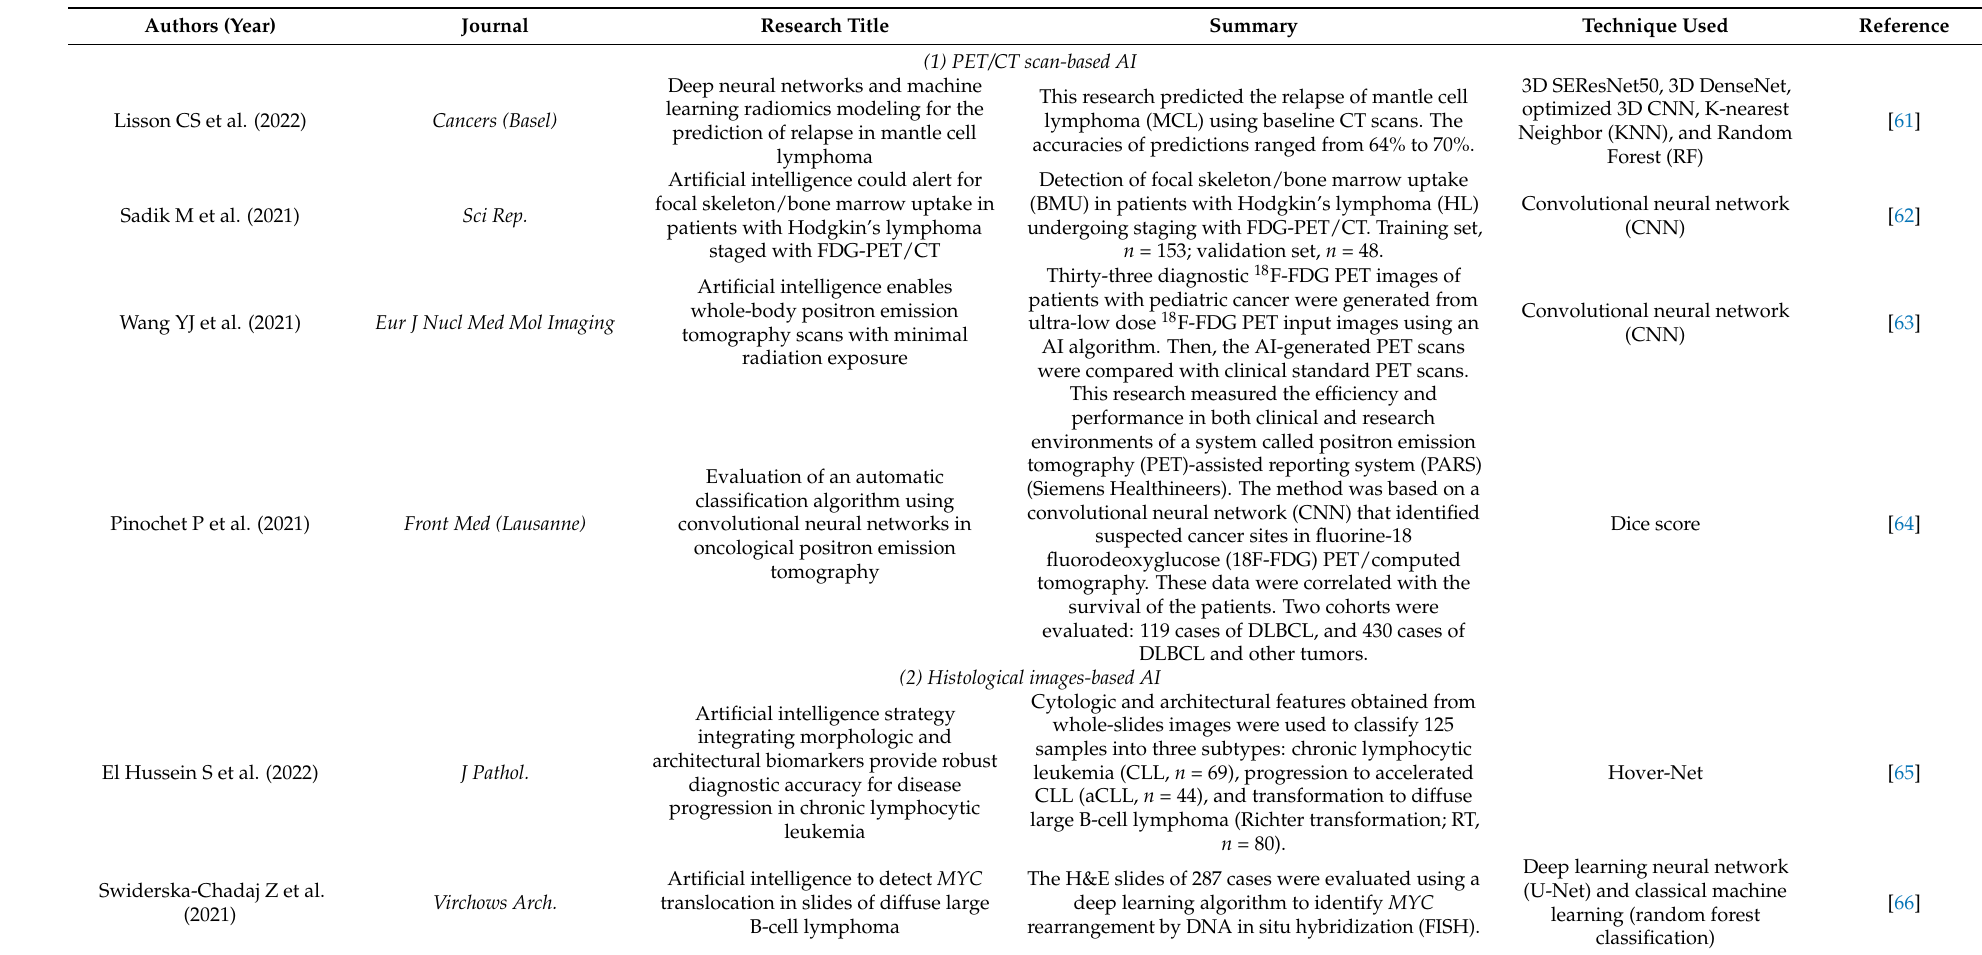
Table 4. Update on the latest progress made in hematological malignancies using artificial